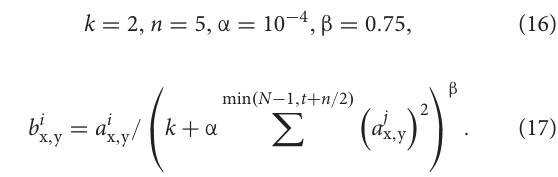
which indicates the reliability of the classification results.